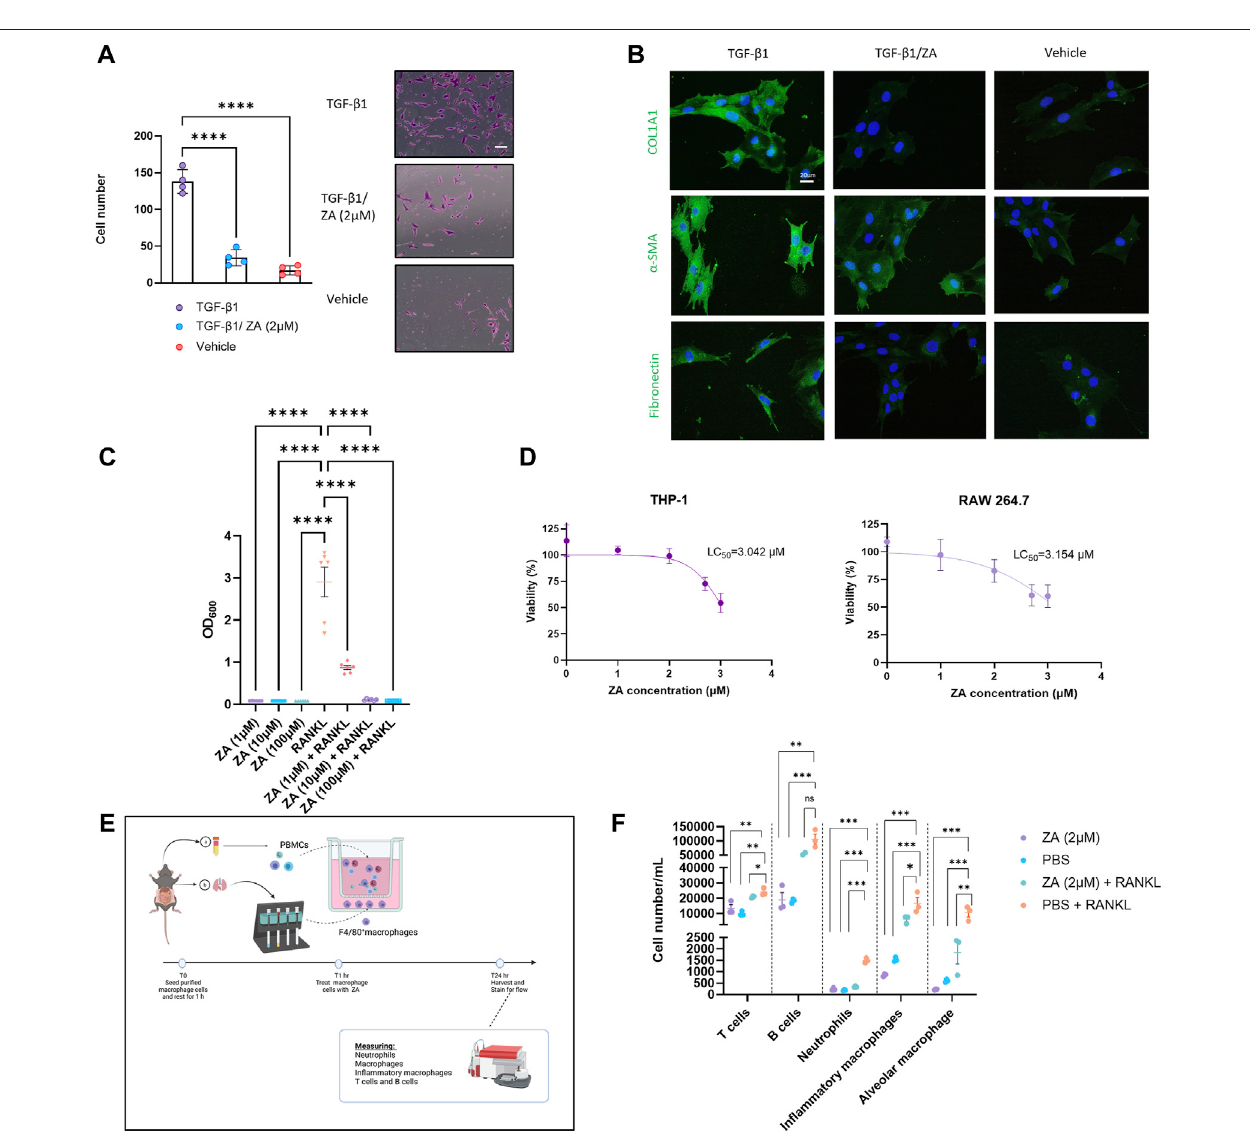
FIGURE1| Zoledronicacid(ZA)inhibits invitro transwellmigrationand fi broticmarkerexpression,whilstsimultaneouslyreducingnuclearfactorkappa-light-chain- enhancer of activated B cells (NF- κ B) signaling and immune cell recruitment. (A) ZA reduced myo fi broblast migration and proliferation in a transwell assay compared to vehicle treatment and no treatment controls (Student ’ s t -test, p < 0.005 (***) and p < 0.0001 (****), with representative myo fi broblast cells in lower chamber of transwell insert following 48 h shown. (B) Immunostaining of fi broblast cells following 48 h of TGF- β 1 treatment, with ZA treatment displaying visually reduced levels of collagen, fi bronectin and alpha smooth muscle actin ( α -SMA) compared to no treatment control. (C) RAW264.7 and THP1-Blue ™ NF- κ B cells were subjected to receptoractivatorofnuclearfactorkappabeta(RANKL)treatmentfor48h,withNF- κ Bsignalingsigni fi cantlyreducedbyZA( p < 0.0001)and (D) lowlevelsofcytotoxicity reported for ZA against both THP-1 and RAW 264.7 cells. (E,F) Isolated murine macrophage cells (bottom well) and peripheral blood mononuclear cells (PBMCs) (top well) were exposed to RANKL in a transwell system, with signi fi cant reductions in T cells, neutrophils, and macrophage cells following ZA treatment (drug-treated samples were compared to untreated control samples using a one-way ANOVA followed by a Dunnett ’ s post-hoc test; N = 3 technical replicates, from 3 biological replicates per measurement).